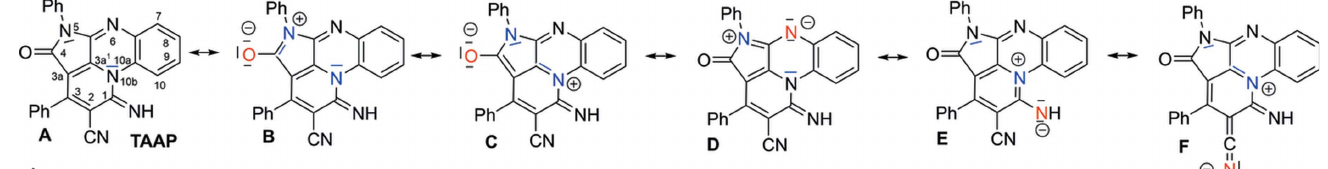
Figure 2 Zwitterionic resonance structures of